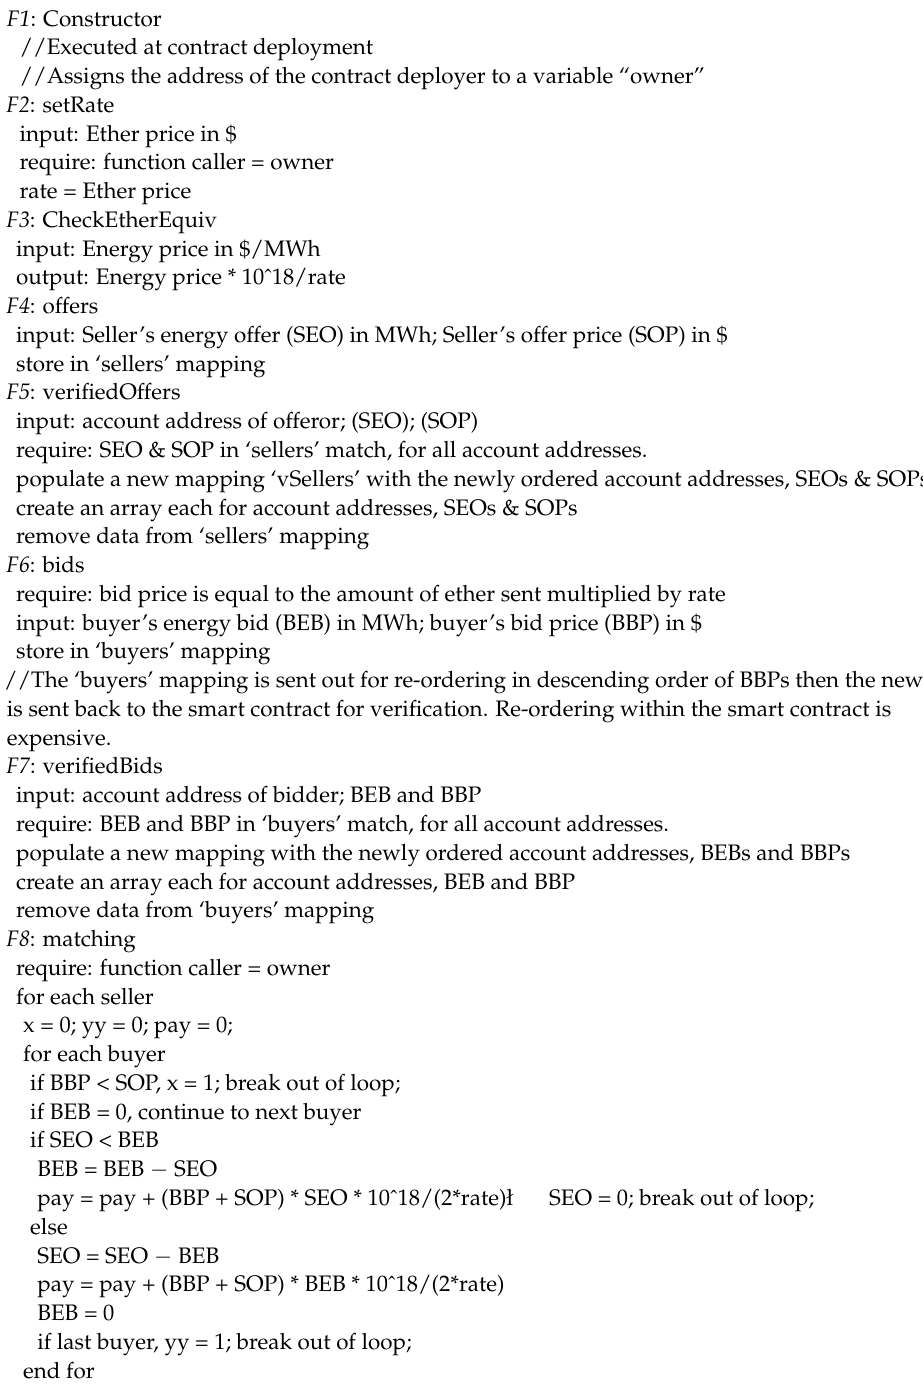
Algorithm 1 Smart contract-based energy double auction